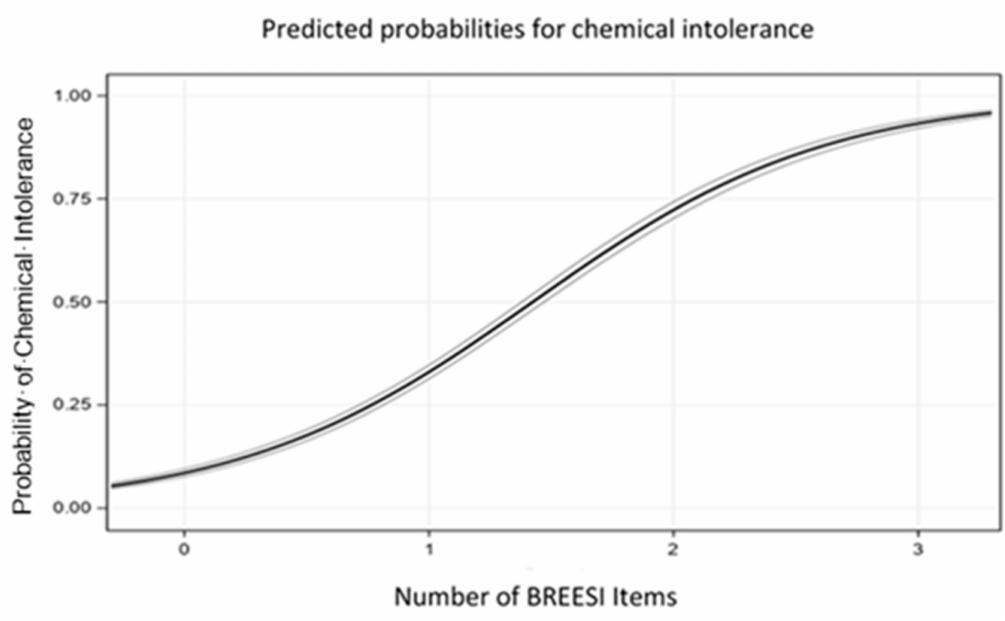
Figure 2. Predicted probability of chemical intolerance versus number of BREESI items endorsed. BREESI statistical validity